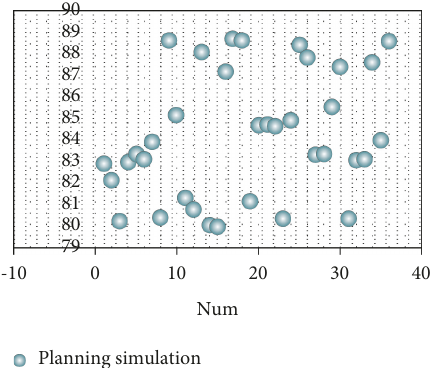
Figure 11: Simulation statistics of the development path planning of the sports wellness